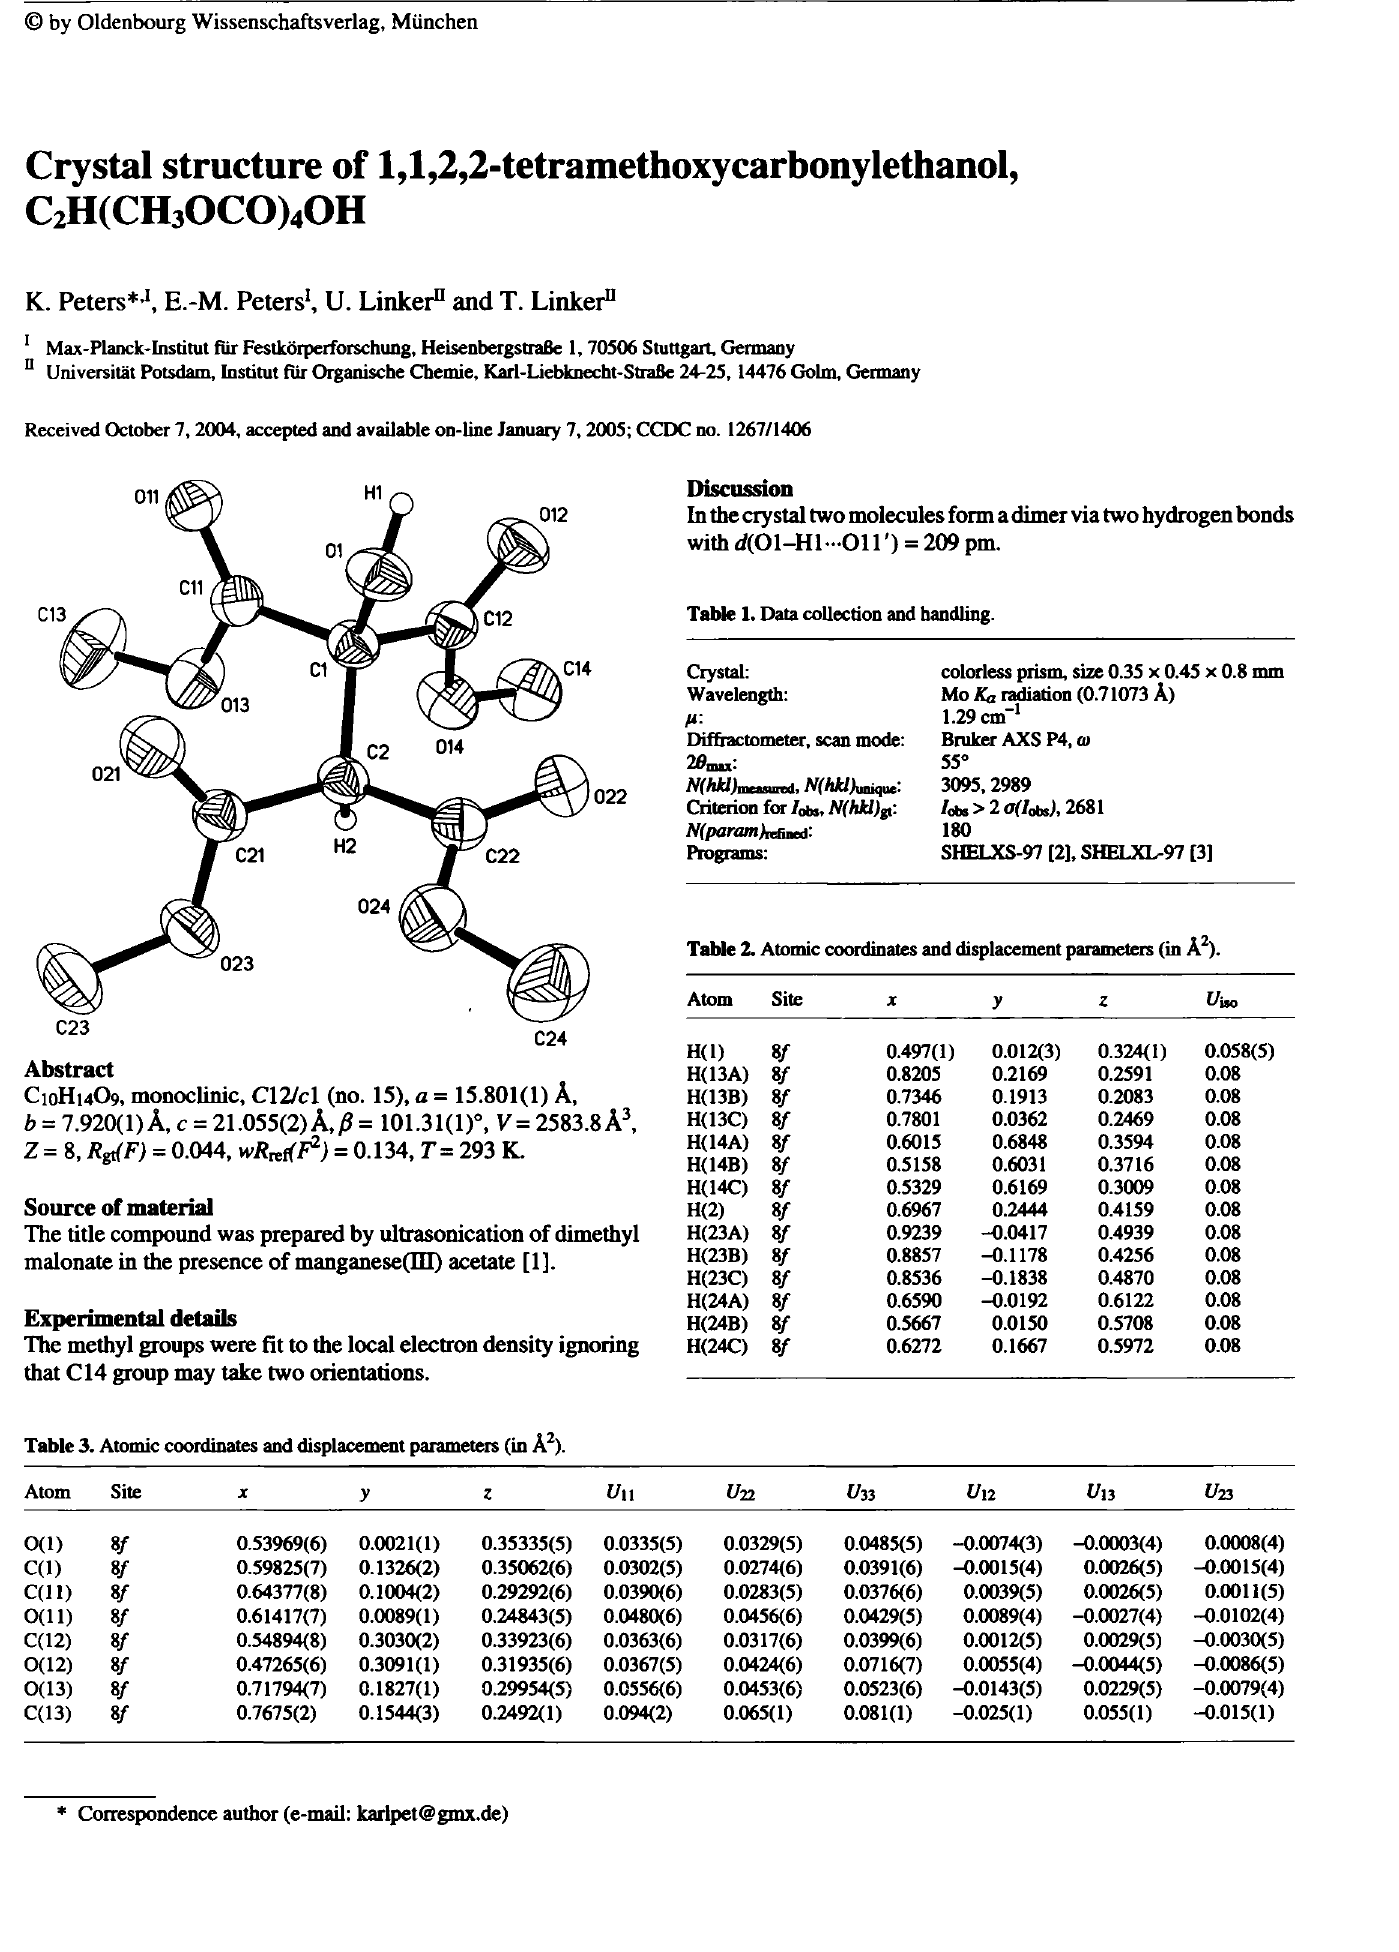
Table 3. Atomic coordinates and displacement parameters (in Ä 2